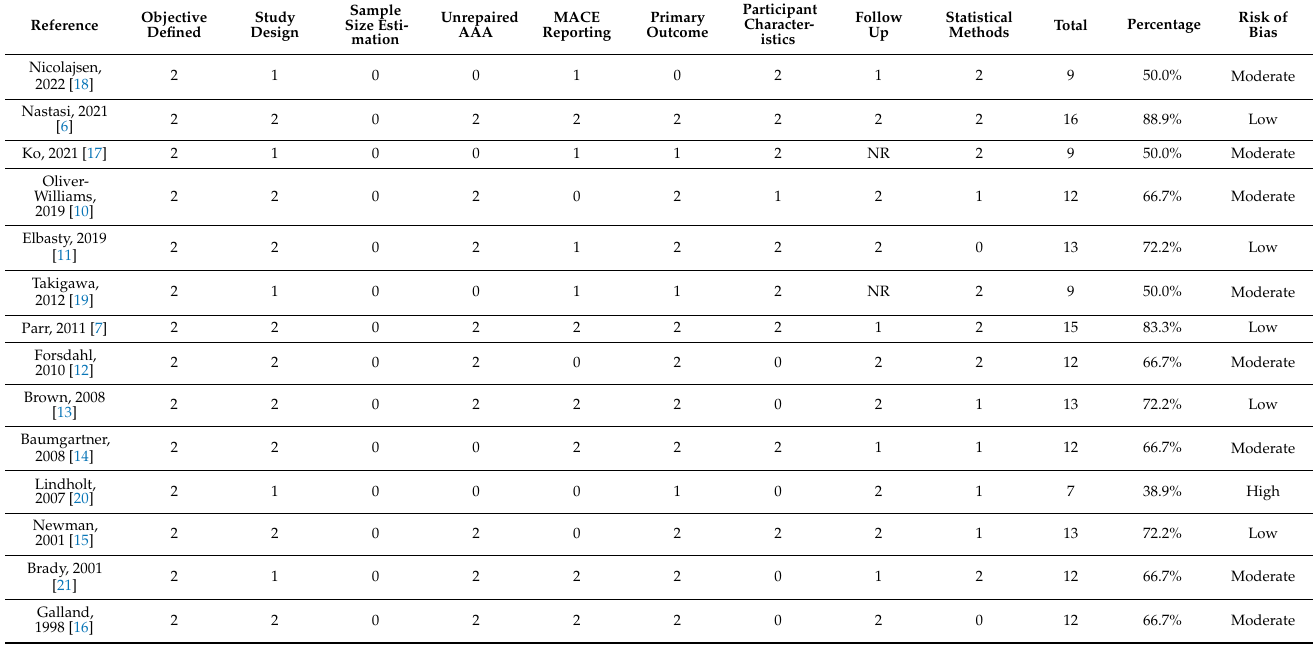
Table 2. Risk of bias of included